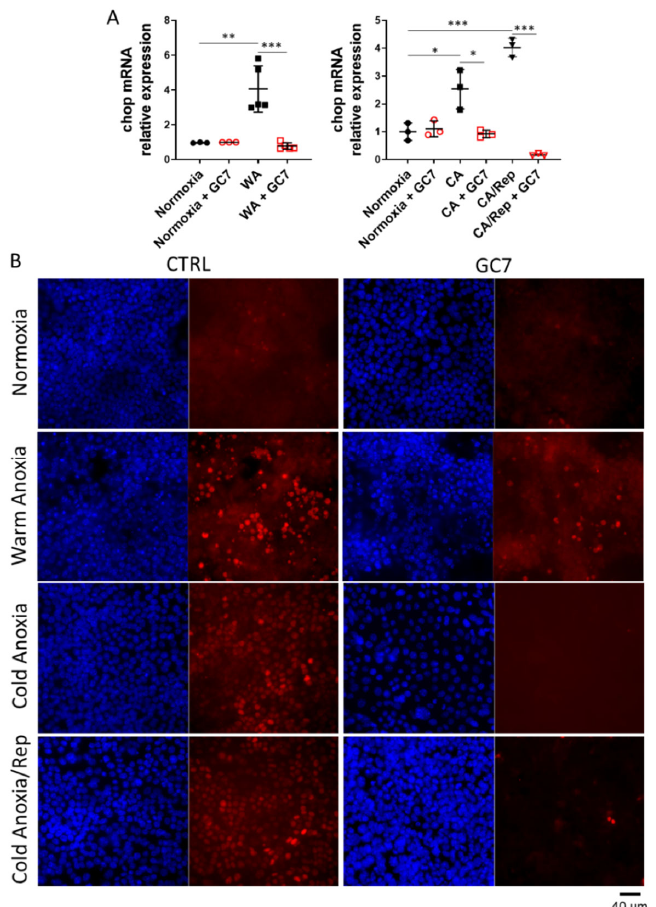
Figure 2. GC7 pretreatment prevents the rise in CHOP expression and its nuclear translocation following anoxia and reoxygenation. PCT cells were pre-treated for 8 h either with a vehicle or with 30 µ M GC7 and 24 h later, exposed to either normoxia, warm anoxia ( ≤ 0.1% O 2 at 37 ◦ C for 24 h), or cold anoxia ( ≤ 0.1% O 2 at 4 ◦ C for 16 h) followed or not by a normothermic reoxygenation step (“Rep”, 20% O 2 at 37 ◦ C for 2 h). At the end of the experiment cells were either ( A ) lysed for mRNA expression analysis or ( B ) fixed and processed for CHOP immunodetection. ( A ) Scatter plot representation of individual values along with mean ± SD for each condition of chop mRNA n = 3–5, * = p ≤ 0.01; ** = p ≤ 0.001; *** = p ≤ 0.0001. ( B ) Representative images of CHOP immunostaining (red) and nuclei counterstained with DAPI